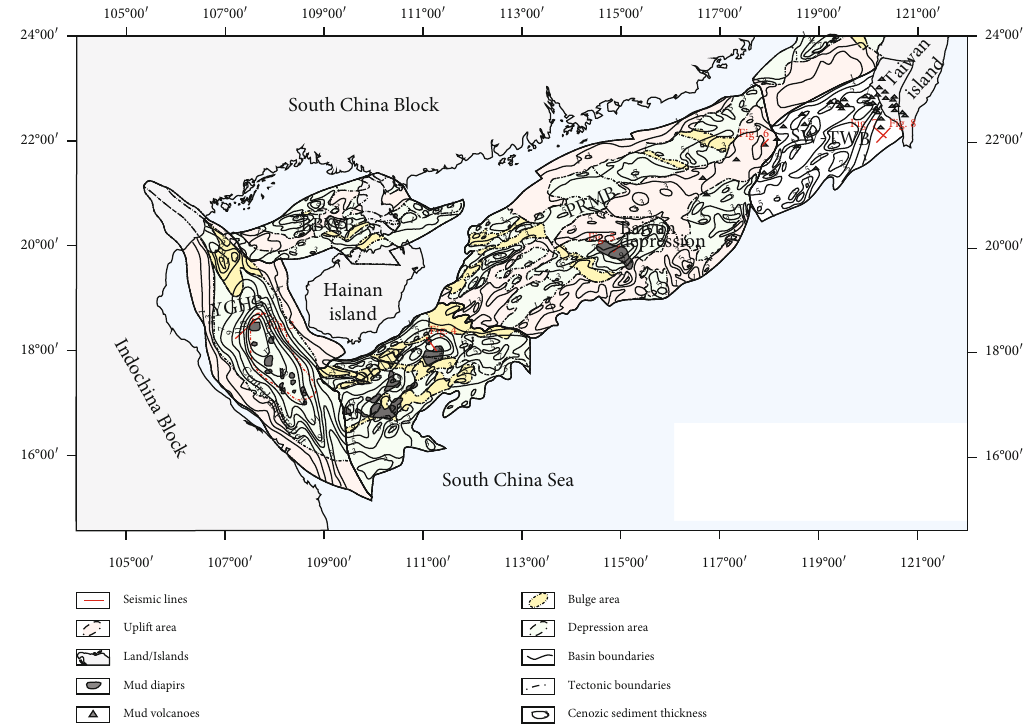
Figure 1: Distribution of mud volcanoes and mud diapirs in the northern margin of the South China Sea. Grey parts indicate mud diapirs of Yinggehai Basin (YGHB), Qiongdongnan Basin (QDNB), and Pearl River Mouth Basin (PRMB); grey triangles indicate mud volcanoes in the Dongsha Islands and Southwest Taiwan Basin (SW-TWB). Red lines indicate the location of seismic lines. Di ff erent colors (pink, yellow, and green) represent uplift, bulge, and depression areas, respectively (modi fi ed from [13, 49]). Black solid lines with numbers represent Cenozoic sediment thickness (modi fi ed from “ Map of Cenozoic Sediment Thickness 1:2 000 000, ” Atlas of geology and geophysics of the South